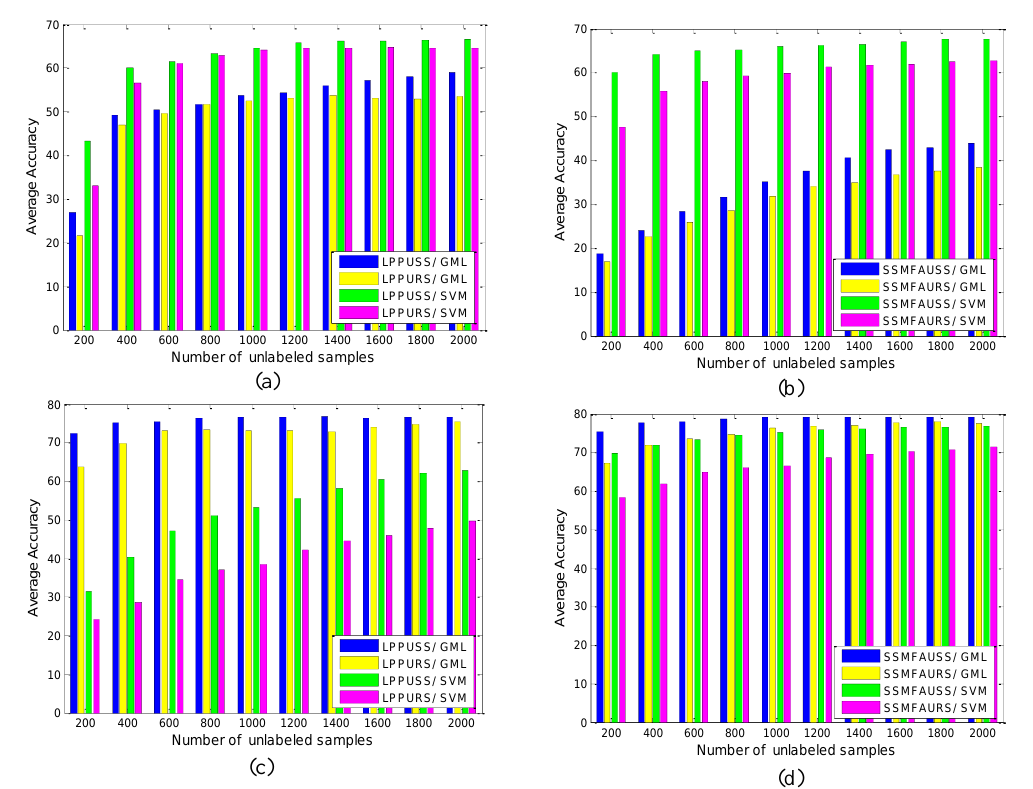
Figure 3. Average accuracy versus the number of unlabeled samples by 10 training samples and 5 and 15 extracted features for GML and SVM classifiers respectively (a) IP, LPP, (b) IP, SSMFA, (c) PU, LPP, (c) PU, Classification results in ill-posed classification problem using versus the number of unlabeled samples for datasets using 10 training samples, 5 and 15 extracted features by GML and SVM SVM classifier and 15 extracted features are reported in Table 1 for PU and Table 2 for IP datasets. In second experiment, classifiers respectively. For both data sets, LPPUSS and number of training samples and extracted features are fixed and SSMFAUSS have better performance compared to LPPURS number of unlabeled samples varies from 200 to 2000 with a and SSMFAURS in poorly-posed and ill-posed situations. For step size increment of 200. Figure 3 shows Average accuracy all methods, the average accuracy improves as unlabeled